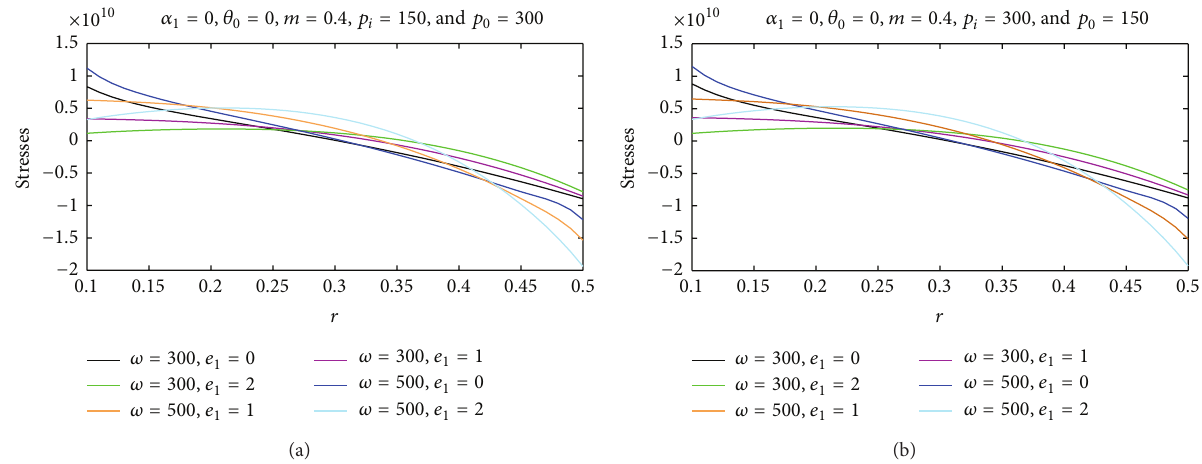
Figure 2: Elastic-plastic stresses in a rotating cylinder with constant thickness and constant density without thermal effects ( 𝜃 0 = 0 ) with parameters 𝑒 1 = 0, 1, 2 and strain hardening measure 𝑚 = 0.4 under internal and external pressure.